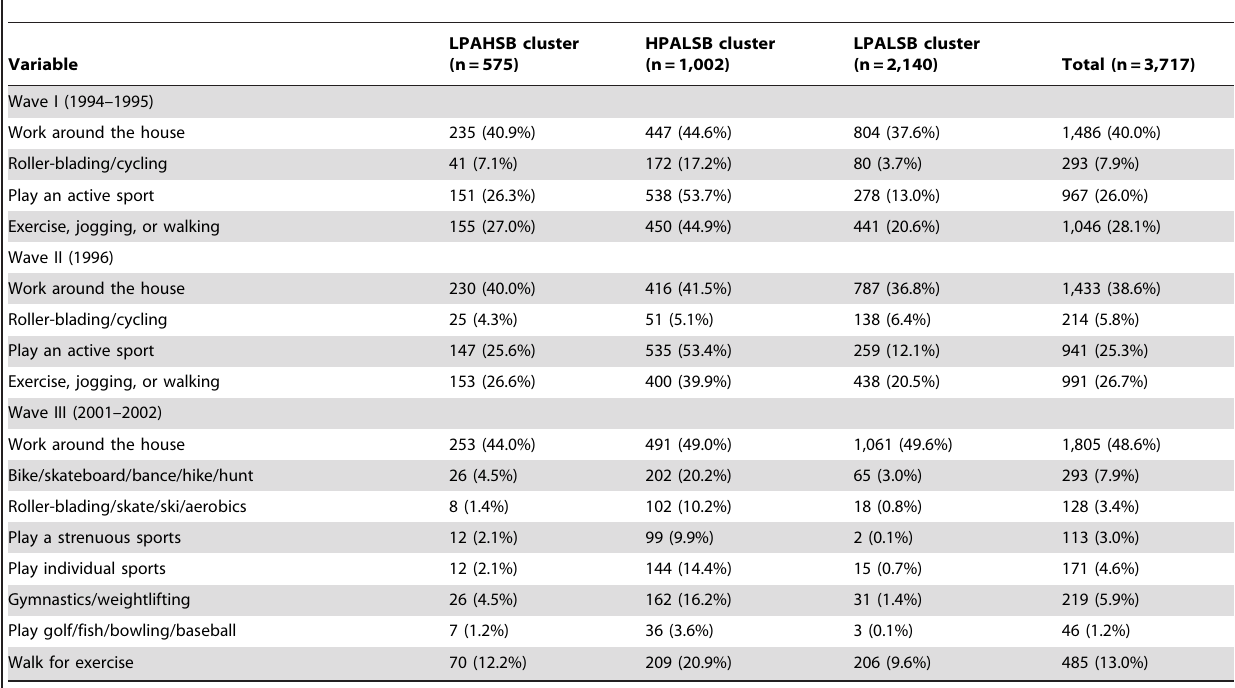
Table 2. Physical activity and sedentary behavior: Proportions of the participants in the three clusters and the total sample who had engaged five or more times in the week preceding the